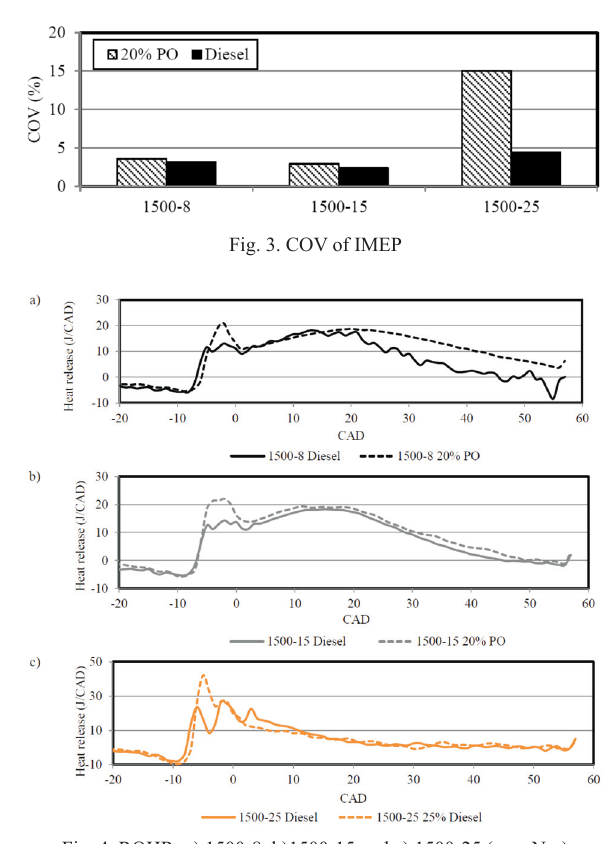
Fig. 4. ROHR: a) 1500-8, b)1500-15 and c) 1500-25